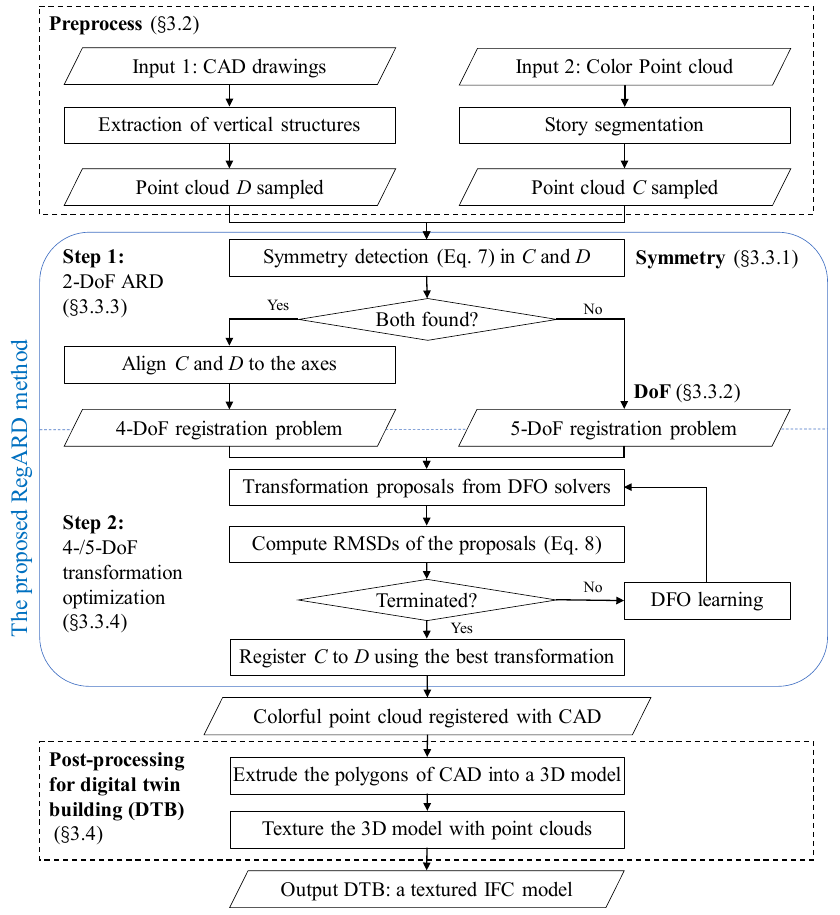
Figure 2. Flowchart of the proposed RegARD method for